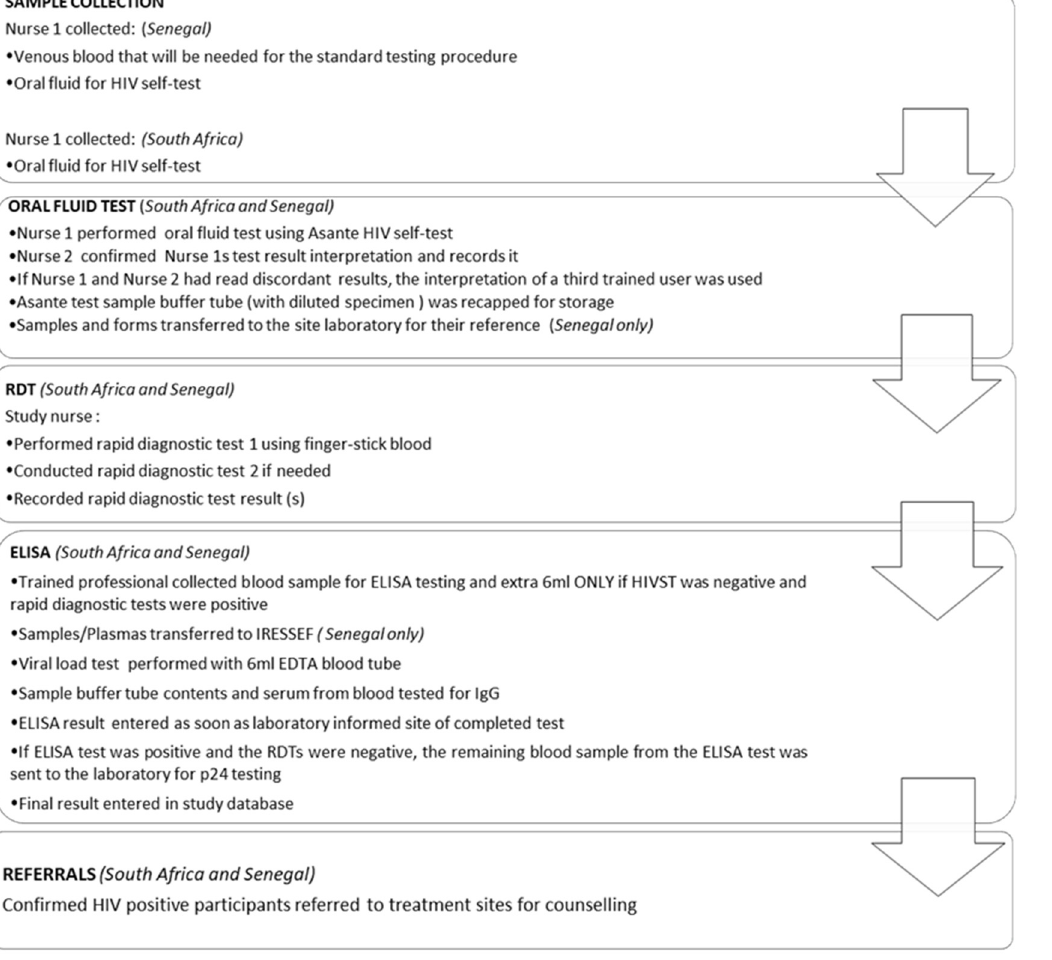
Figure 3. Study workflow.